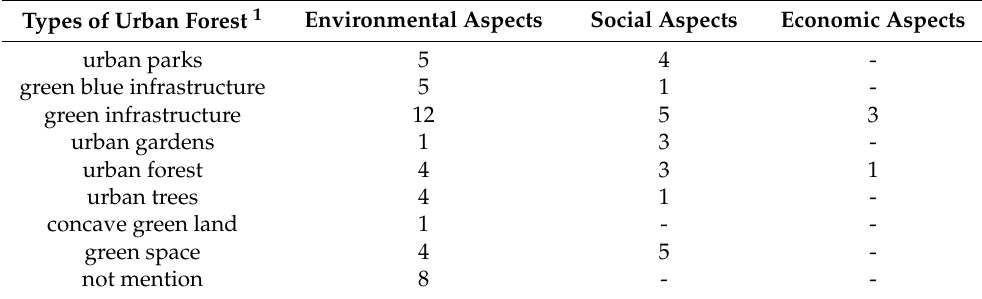
Table 5. The typologies of urban forest and presence of benefits in analyzed